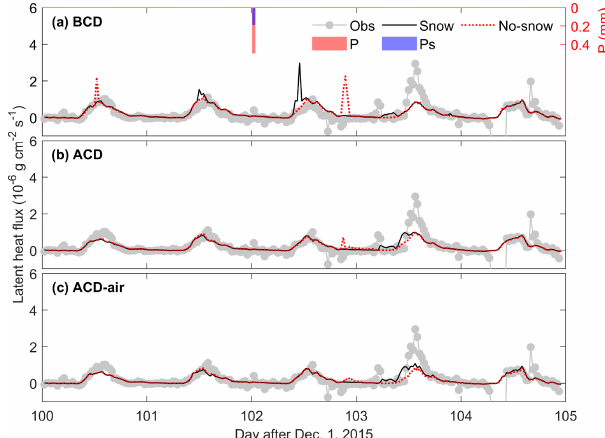
Figure 6. Observed and model simulated latent heat flux using (a) BCD, (b) ACD, and (c) ACD-air soil models with and with- out the snow module of a typical 5d freezing period (from the 10th to 14th day after 1 December 2015). P is the precipitation and Ps is the snowfall. All precipitation is in the form of snowfall.